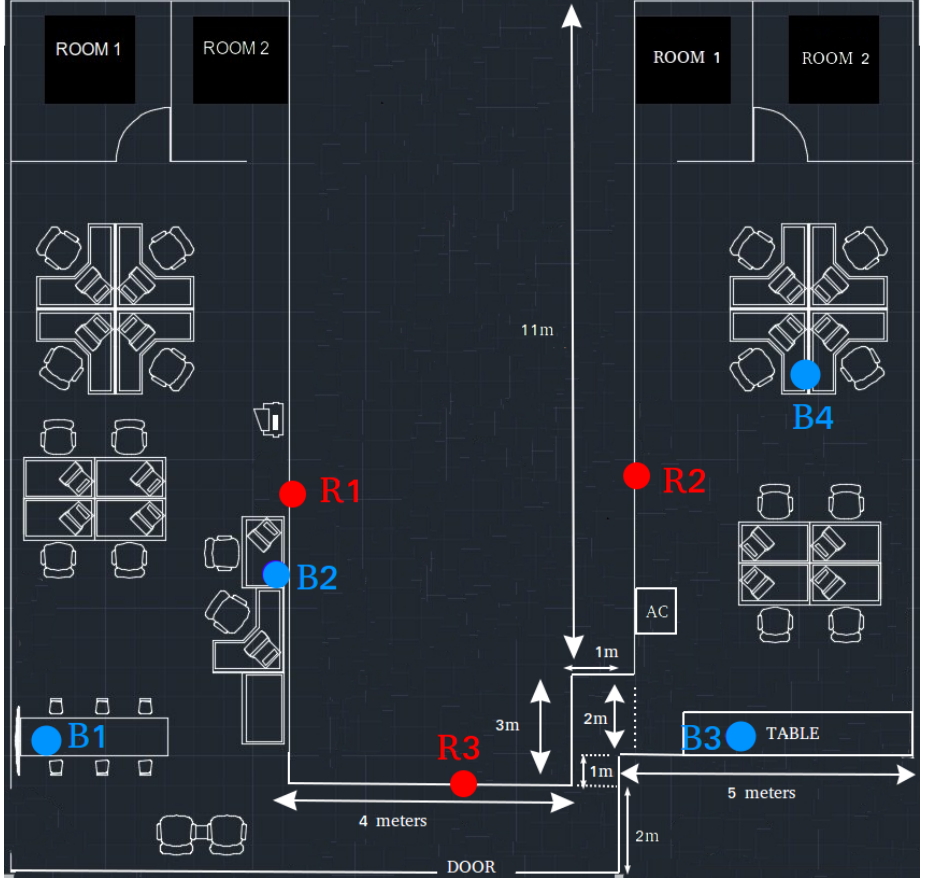
Figure 9. Indoor environment for the real-world localization experiments.